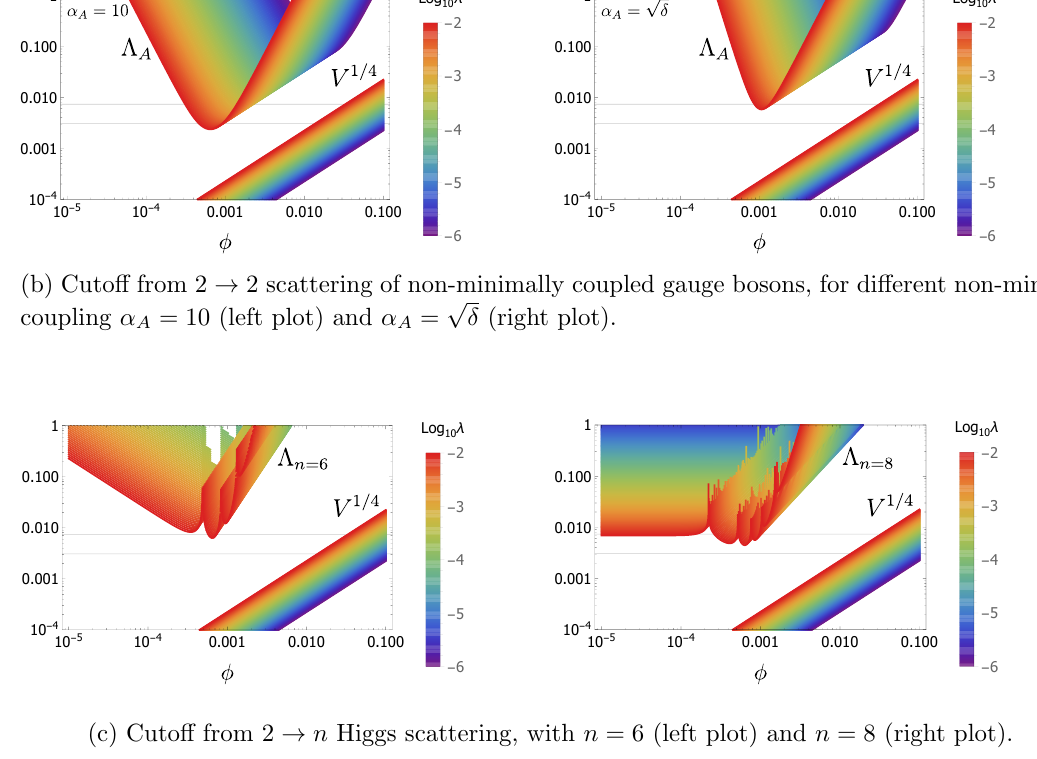
Figure 1. Unitarity cuto(cid:11) (cid:3) i for di(cid:11)erent interactions as a function of the (cid:12)eld (cid:30) in Planck units; also shown is V 1 = 4 . In all (cid:12)gures horizontal gridlines correspond to f V 1 = 4 independent of (cid:21) . In the plots (cid:21) varies between 10 (cid:0) 2 and 10 (cid:0) 6 .